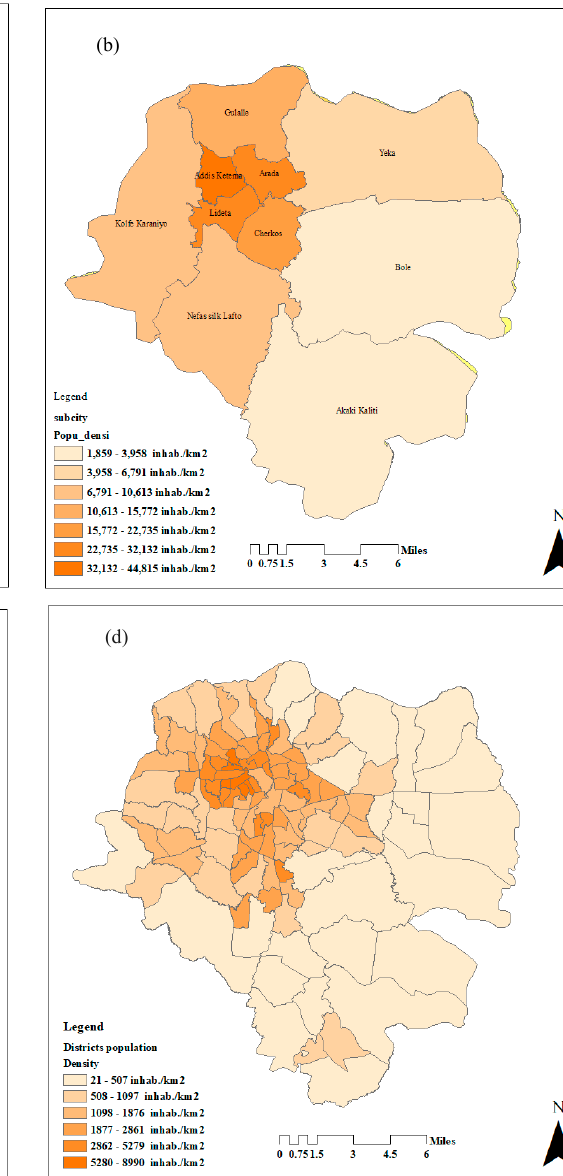
Figure 3. Population density and per capita UGS in Addis Ababa: ( a ) urban green space per capita in the sub-cities; ( b ) population density in the sub-cities; ( c ) urban green space per capita in the districts; ( d ) population density in the districts. Note: inhab. means inhabitants.